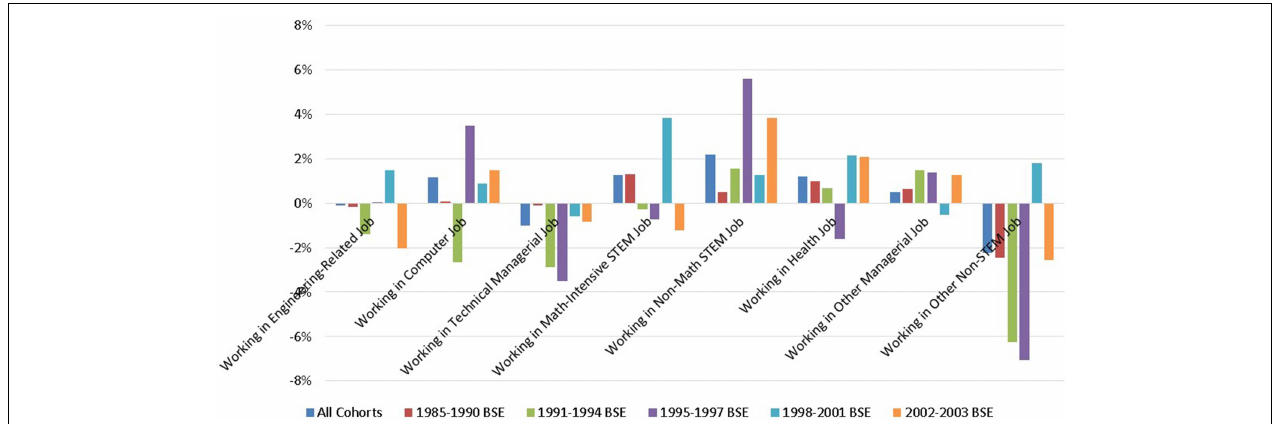
FIGURE 8 | Cohort-specific gender differences in the probability of being in occupations other than engineering among those working full-time (at 7–8 years post-BSE). Data Source: NSF SESTAT Surveys 1993–2010.